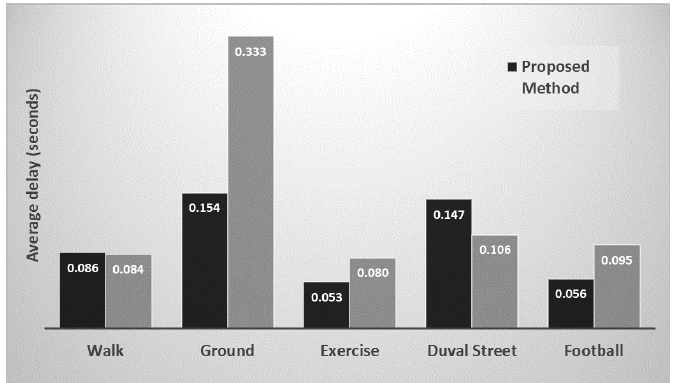
Figure 8. Average delays during the reception of each consecutive frame at the receiver comparing the proposed method with the All Frames method (plotted as gray